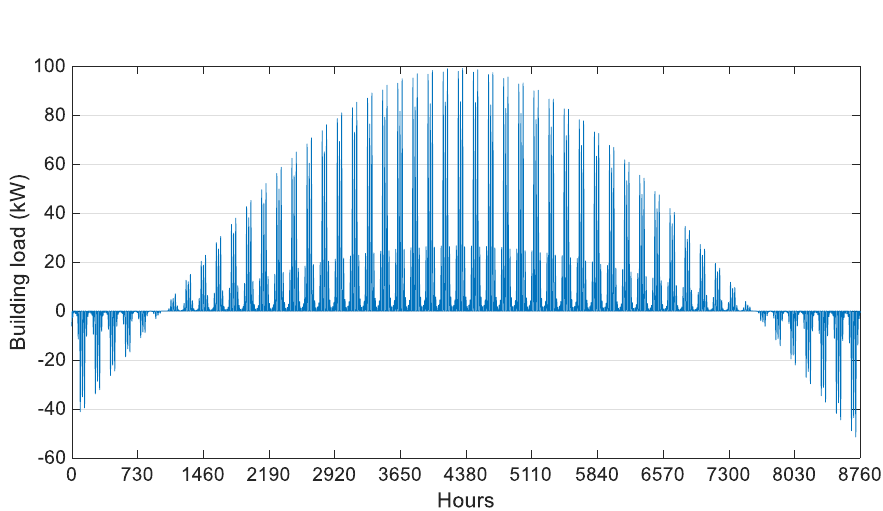
Figure 5. Annual building load profile (cooling (+) and heating (−)).